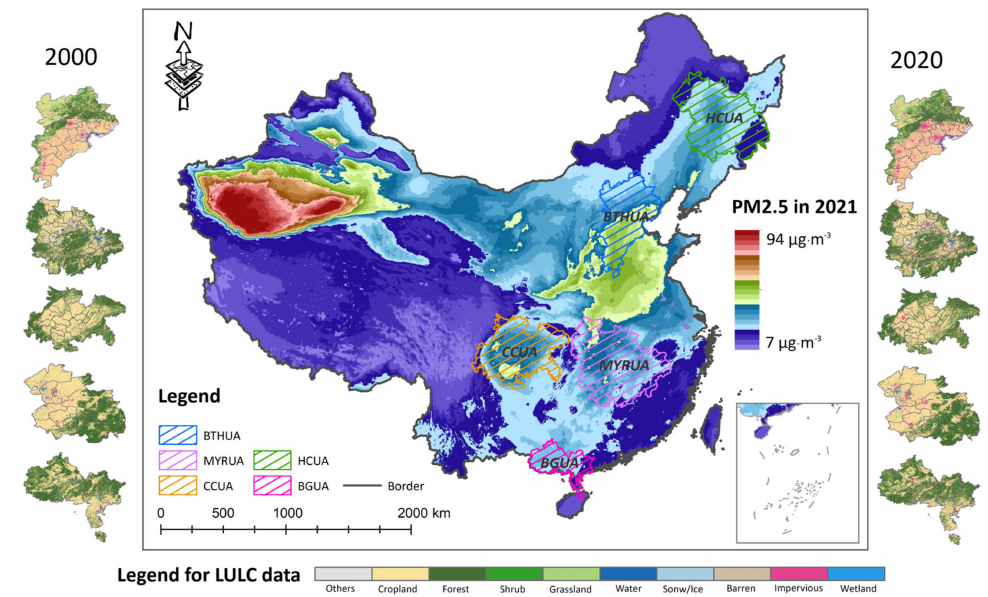
Figure 1. UA locations in China. The left and right panels show land use and land cover (LULC) information for each UA in 2000 and 2020, respectively. The LULC data used were from the GLUD dataset (https://zenodo.org/record/5210928, accessed on 17 May 2022) developed by Yang and Huang